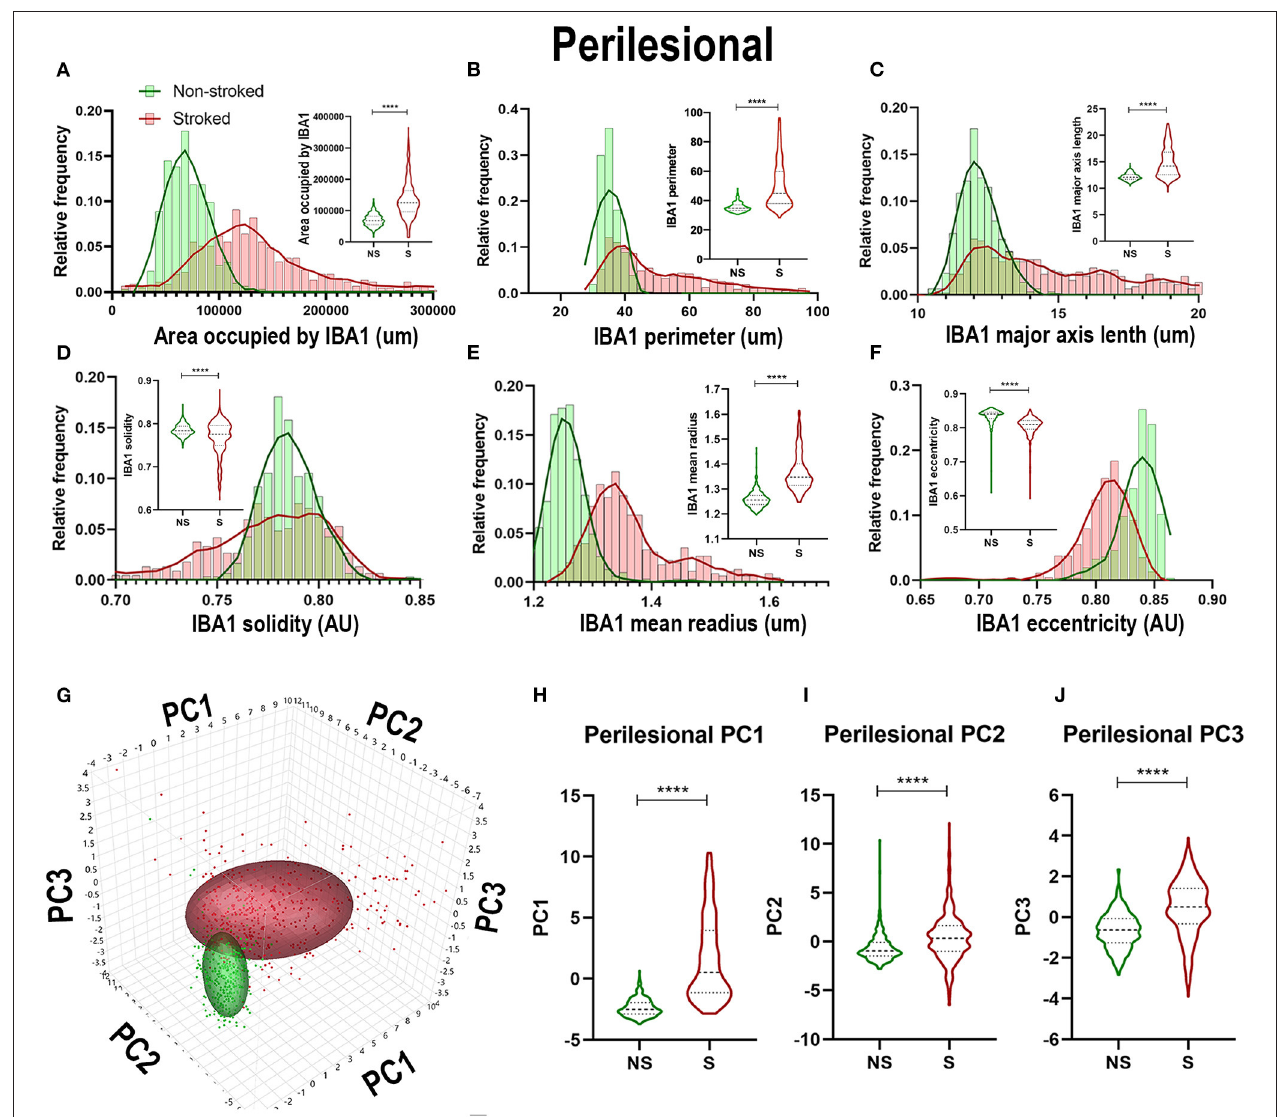
FIGURE 3 | Stroke resulted in an amoeboid morphological transition of IBA1 + areas in perilesional tissue. Significant ( p < 0.0001) increases in IBA1 + area occupied (A) , perimeter (B) , major axis length (C) , and mean radius (E) were observed in perilesional ROIs of S ( n = 452 ROIs) animals compared NS ( n = 304 ROIs) animals. There was a significant ( p < 0.0001) decrease in solidity (D) , and eccentricity (F) of IBA1 + perilesional ROIs in S animals compared to NS animals. PCA (G) analysis showed a significant ( p < 0.0001) increase in PC1-3 (H–J) in S compared to NS animals. **** p < 0.0001.